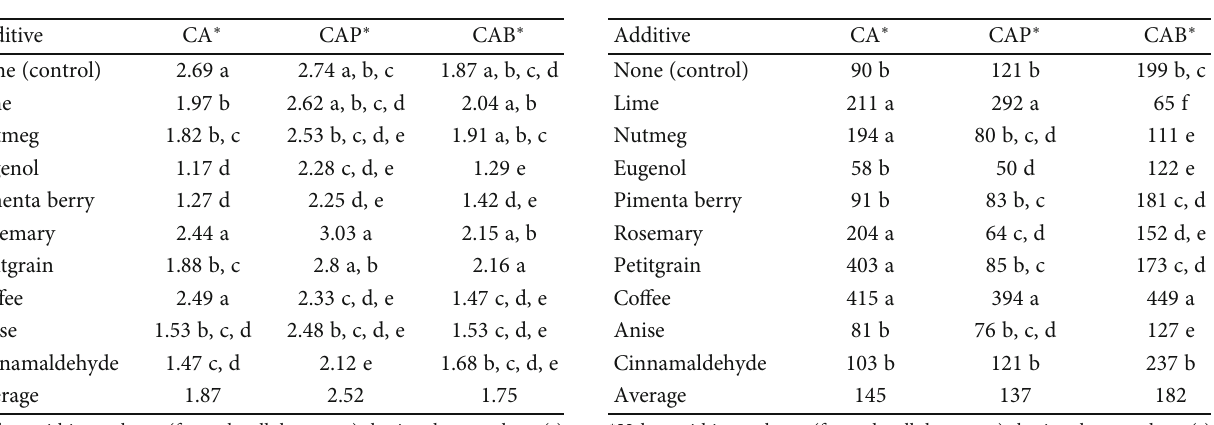
Table 6: Opacity data (in units of A-mm -1 ) for cellulose ester-EO fi